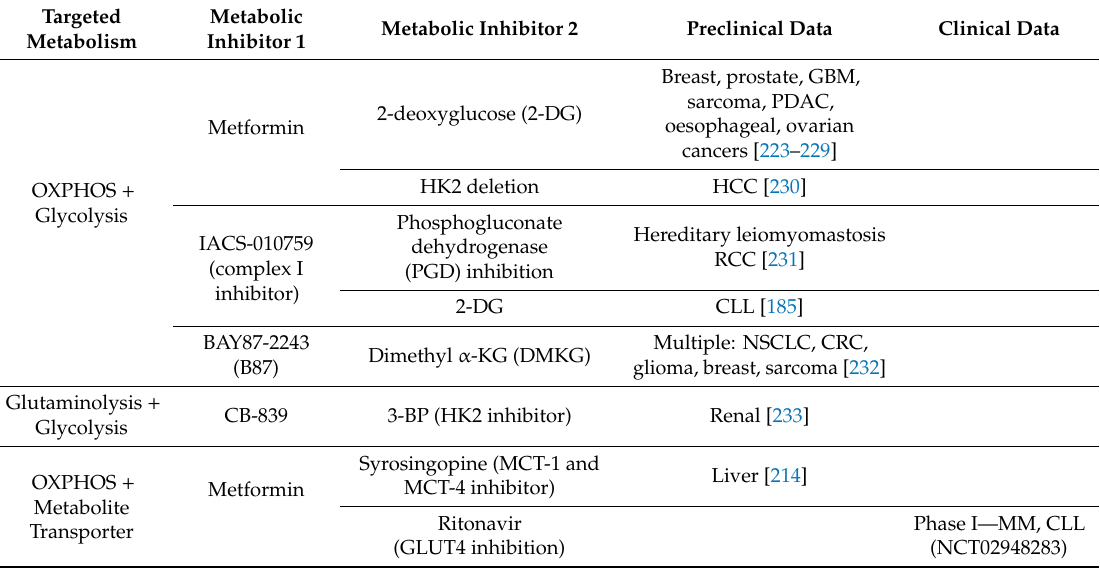
Table 1. Dual metabolic inhibitor combinations for cancer